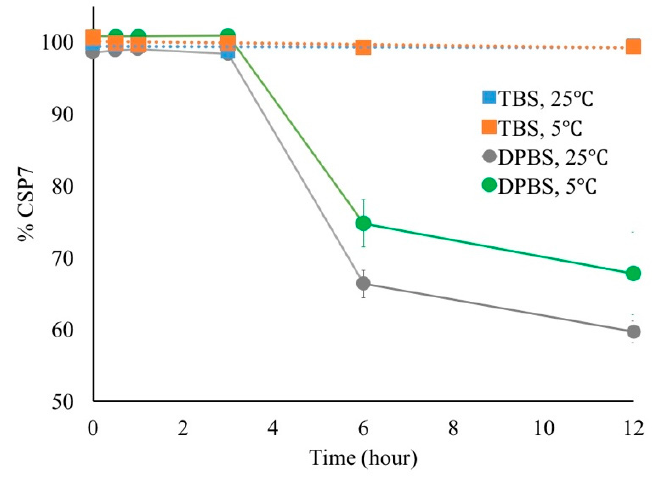
Figure 6. Recovery of CSP7 acetate in bulk solution after mechanical shaking.